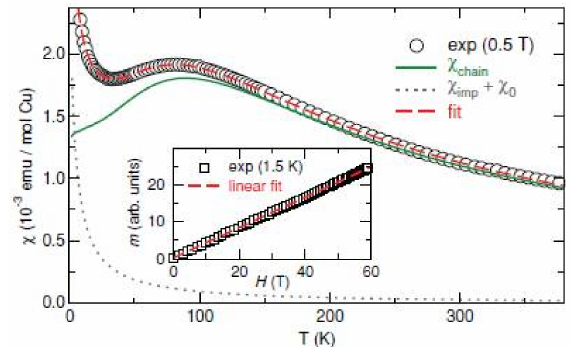
Figure 6. Magnetic susceptibility measured for CaCu 2 (SeO 3 ) 2 Cl 2 (circles) and the uniform spin-1/2 chain model fit (dashed line). Heisenberg chain (solid line) and impurity (dotted line) contributions to the fitted curve are shown. The inset shows the high-field magnetization curve (squares) with a linear fit (dashed line) Reprinted figure with permission from [28] Copyright (2011) by the American Physical Society.